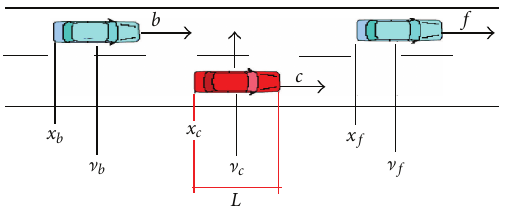
Figure 2: Lane change